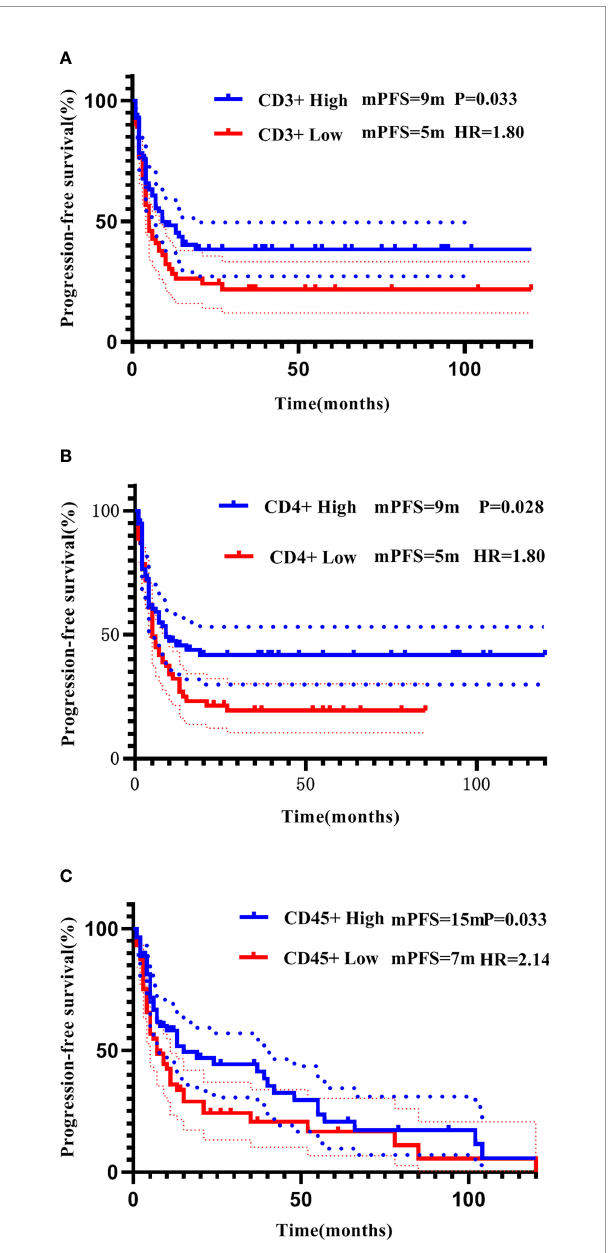
FIGURE 5 | Correlation of CD3+ (A) , CD4+ (B) , and CD45+ (C) with PFS in patients with mTNBC addressed by the Kaplan-Meier method and log-rank test.